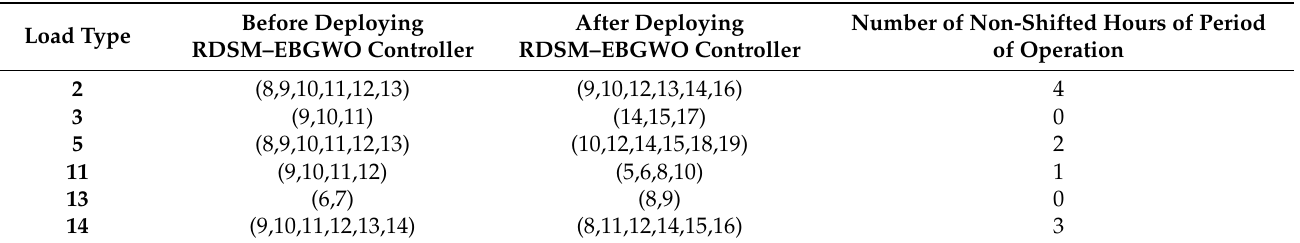
Table 5. Period of operation of user comfort loads before and after deployment of RDSM–EBGWO controller.